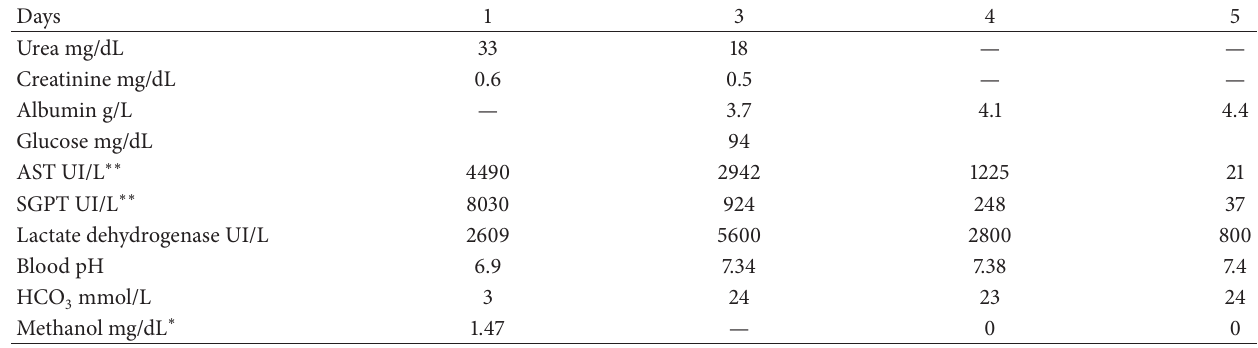
Table 2: Evolution of laboratory